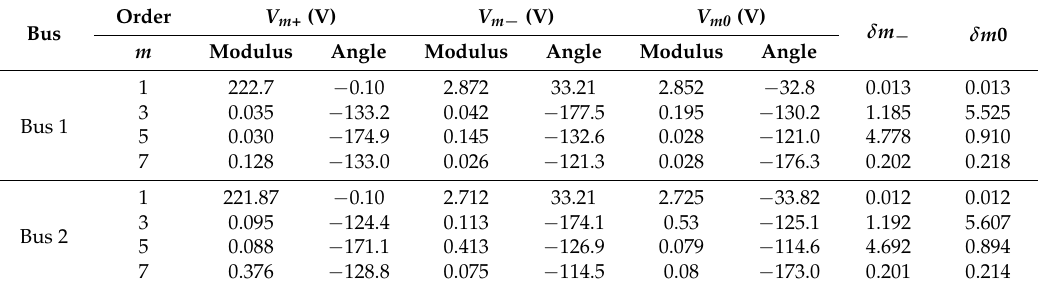
Table 4. Harmonic line-to-neutral voltage in sequence components and voltages unbalance factors.